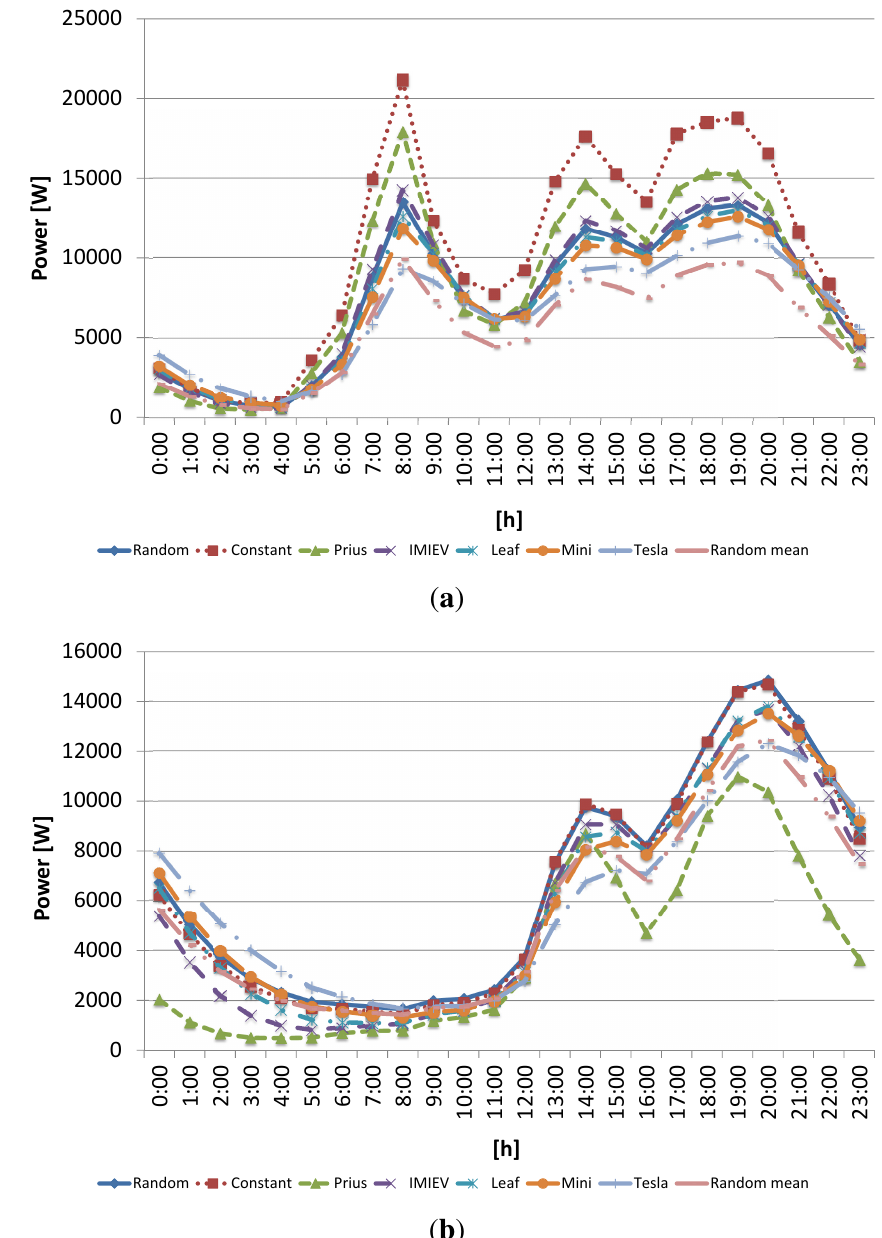
Figure 11. Recharge profile of 1000 EVs distributed along a 53 node low voltage grid [W]. ( a ) Recharge after each trip; ( b ) Recharge at the end of all day